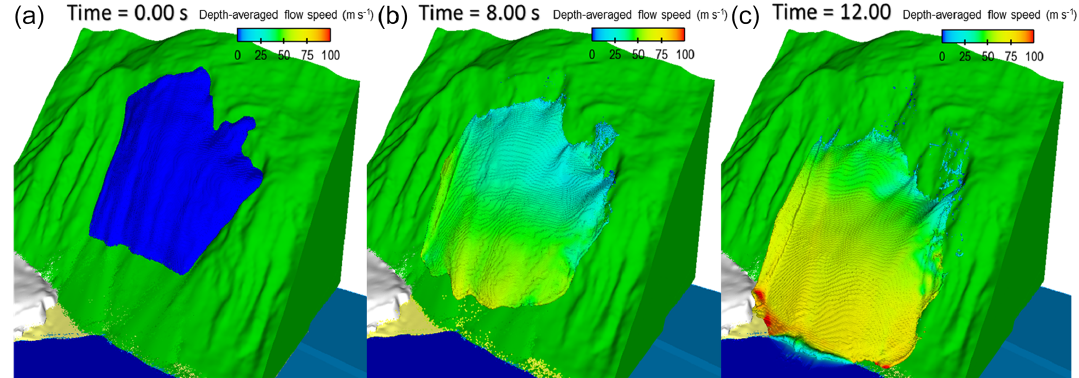
Figure 7. Fluid model at (a) 0s, (b) 8s, and (c) 12s impacting the sea, coloured by the depth-averaged flow speed in (ms − 1 ) with a range of 0–100ms − 1 . Uniform grid resolution of 5m.